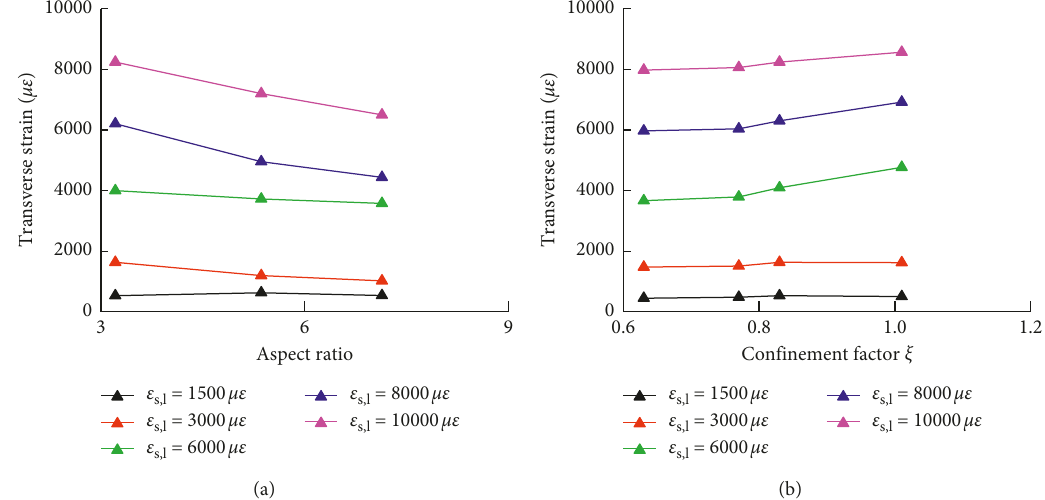
Figure 12: Transverse strain variation of CFST-3. (a) Transverse strain versus aspect ratio; (b) transverse strain versus confinement